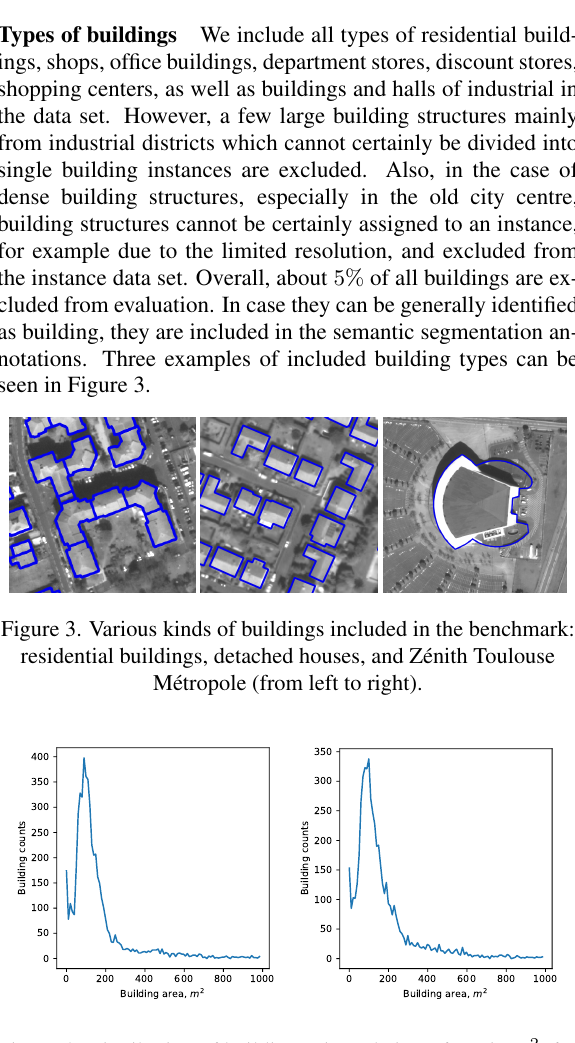
Figure 4. Distribution of buildings given their surface, in m 2 , for the training and test sets. Values larger than 1000m 2 have been clipped